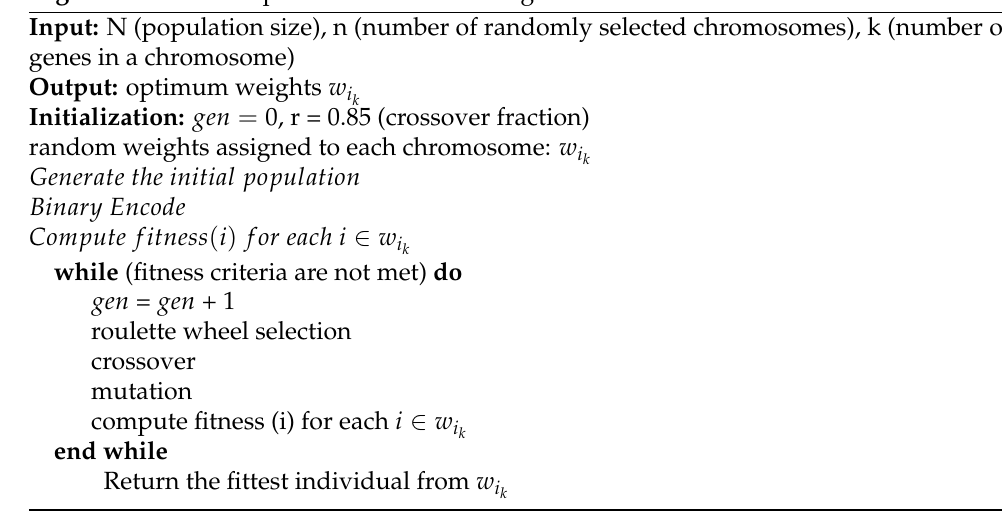
Algorithm 4 Power optimization model using the modified